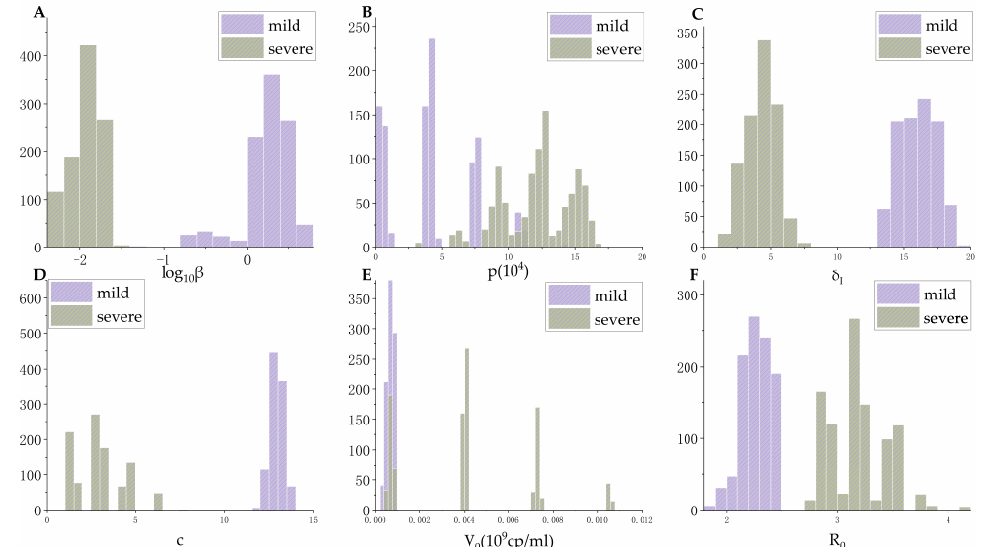
Figure 5. Bootstrap sampling distribution of Model 1 parameters. ( A ) log V 0 ; ( F ) R 0 . The kurtosis of β , p , δ I , V 0 , R 0 of mild patients is − 0.54,0.53, − 0.13,0.0011, − 0.23, − 0.46; the kurtosis of severe patients is − 0.222, − 0.15, − 0.22, − 0.19, − 0.36, − 0.05. Kurtosis can reflect the concentration of data around the mean: the higher the kurtosis is, the greater the concentration is. The distribution of each parameter was found to be significantly different between patients with mild and severe disease using the Mann–Whitney test ( p -value <